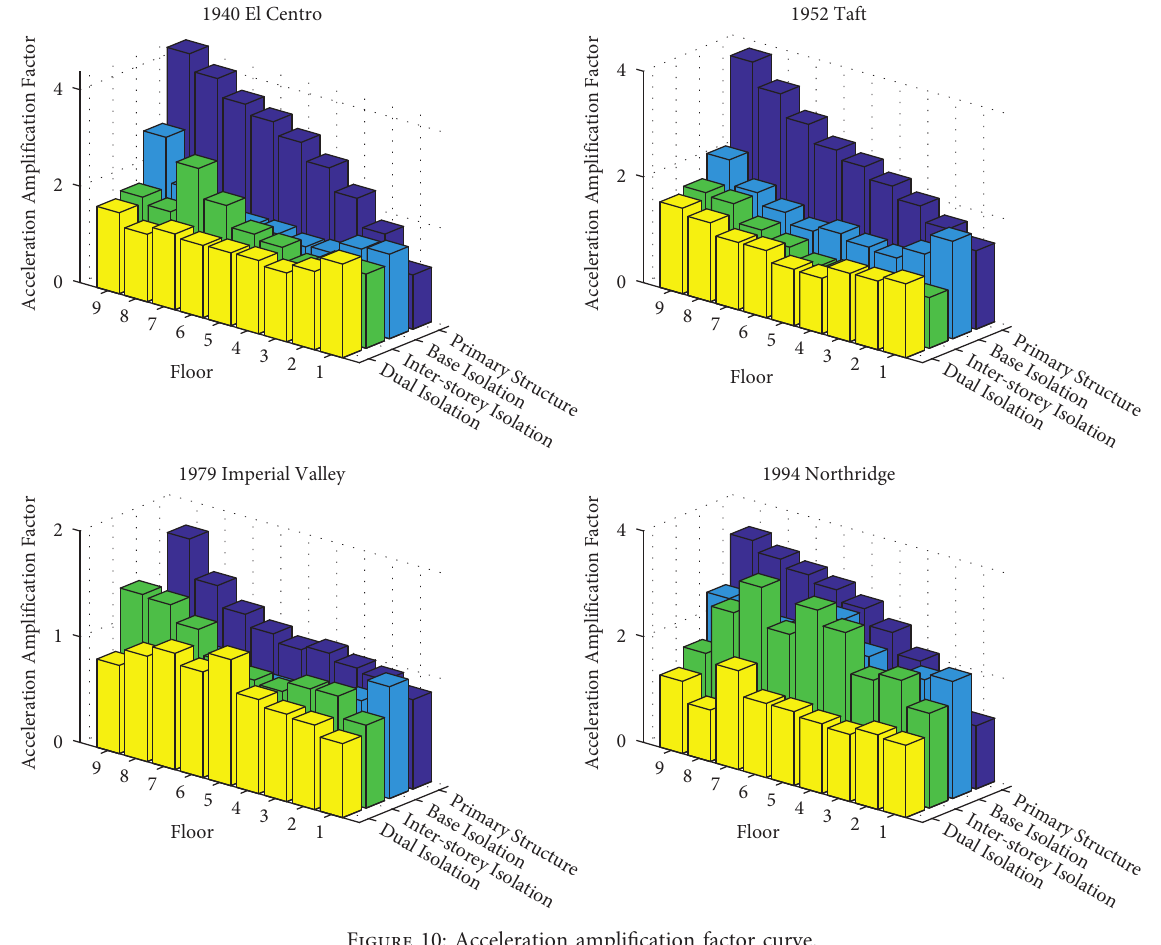
Figure 10: Acceleration amplification factor curve.